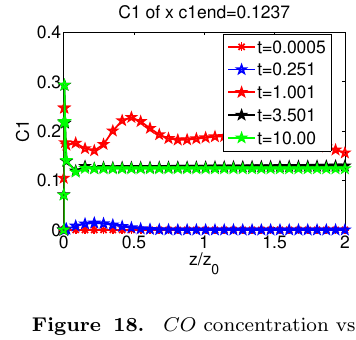
Figure 17. Temperature vs. x with fixed t .